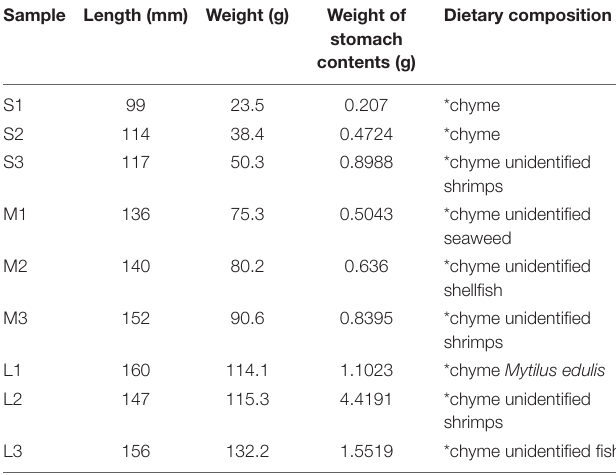
TABLE 1 | The information on the collected fish individuals and the results of the morphological observation. Sample Length (mm) Weight